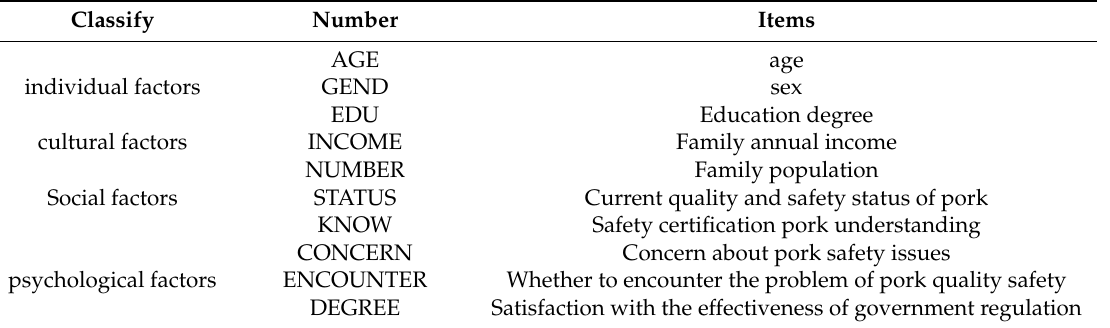
Table 2. Design of consumer social feature items based on Kotler’s behavior selection model.